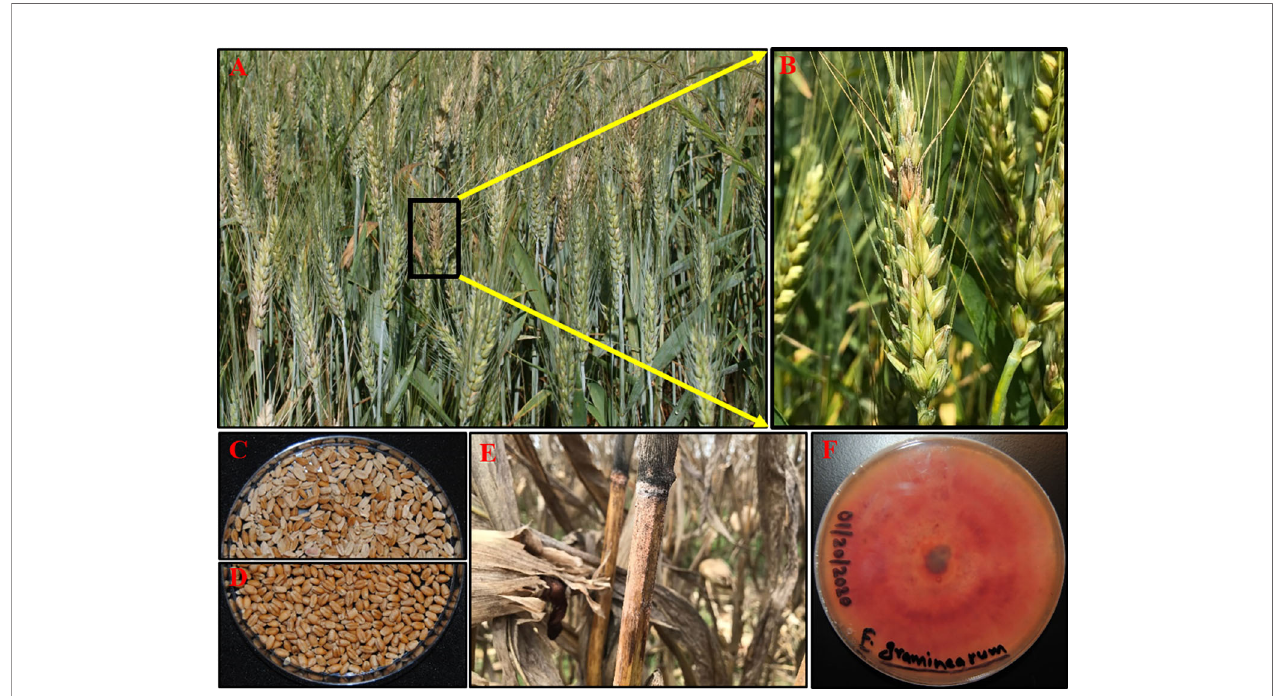
FIGURE 1 | Fusarium head blight (FHB) symptom; FHB disease in the fi eld used to assess FHB incidence (type I resistance) (A) , infected spike with orange-colored sporodochia used to assess FHB severity (type II resistance) (B) , infected seed used to assess Fusarium -damaged kernel (FDK) (type IV resistance) (C) compared to healthy seed lot (D) , F. graminearum overwintering in corn stalk (E) , and FHB isolate cultured in potato dextrose agar (PDA) plate showing characteristic pinkish-red colony (F) . (Source: Figures 1A – F , B.